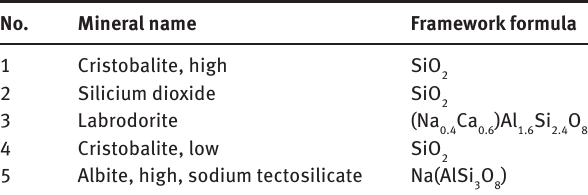
Table 2 Mineral content of Hasankale pumice from XRD analysis.